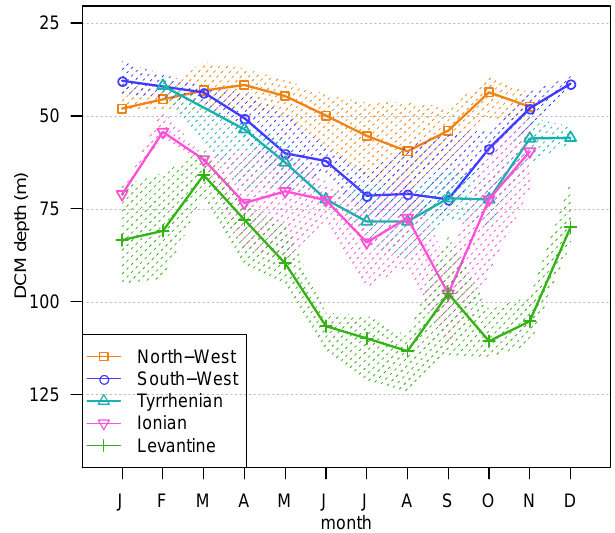
Figure 7. Seasonal evolution of the DCM depth. DCM depths were computed only on profiles of the DCM standard shape (see Sect. 2.3 for an objective definition of DCM shape). Symbols refer to monthly median, whereas dotted areas indicate the interquartile